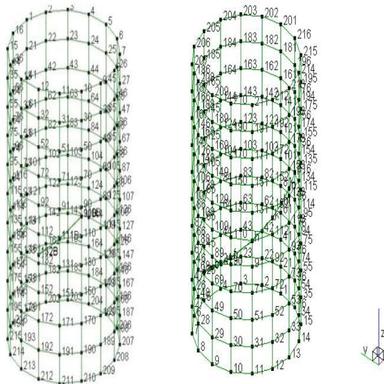
Experimental discretization of the cracked pipe (12 extented to 40 and than to 60 cm).